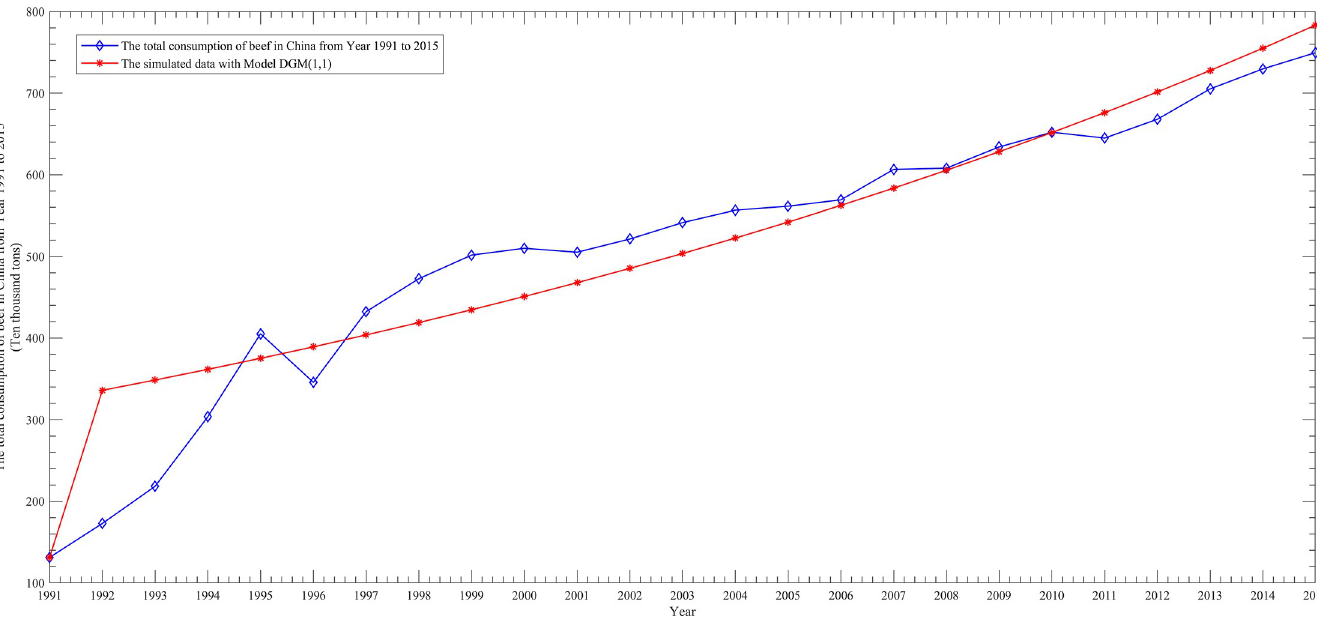
Fig 4. Curves of the actual data and simulated data of the